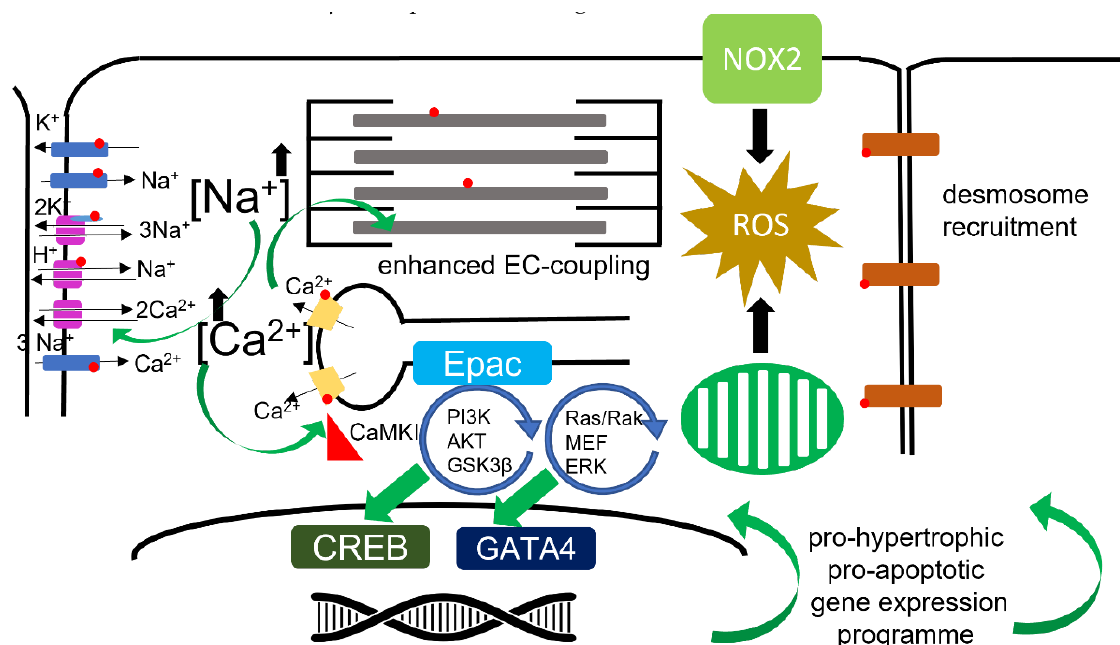
Figure 2. Downstream pathways influencing electrophysiology. This figure represents the pathways downstream of βAR. Kinase pathways and organellar involvement are indicated.